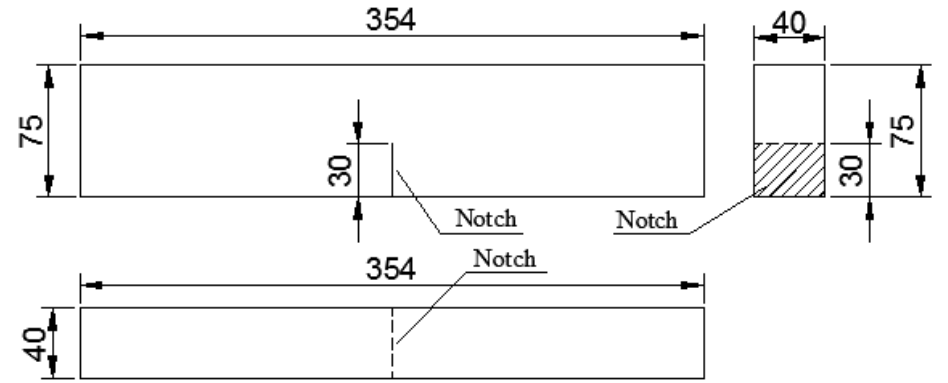
Figure 4. The size of the specimen tested for fracture toughness (Unit: mm).